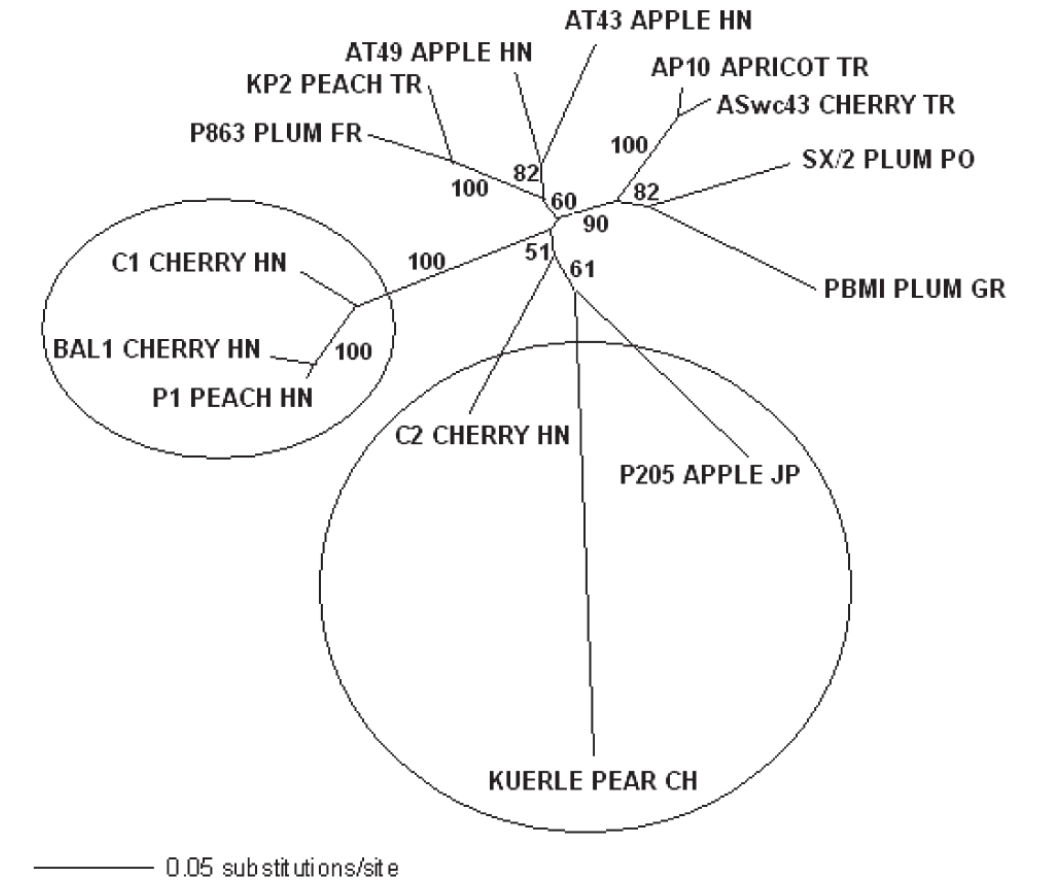
Fig. 4. Unrooted phylogram showing the relationships of the amplified product of Turkish Apple chlorotic leaf spot virus isolates and sequences from GenBank at the nucleotide level. The phylogram was constructed using the neigh- bor-joining method on the Power Macintosh computer program PAUP. The numbers near the nodes were deter- mined by bootstrap analysis with 1000 replicates in percentage, and are only shown when they exceed 50%. PO, Poland; GR, Germany; CH, China; HN, Hungary; JP, Japan; FR, France; TR,